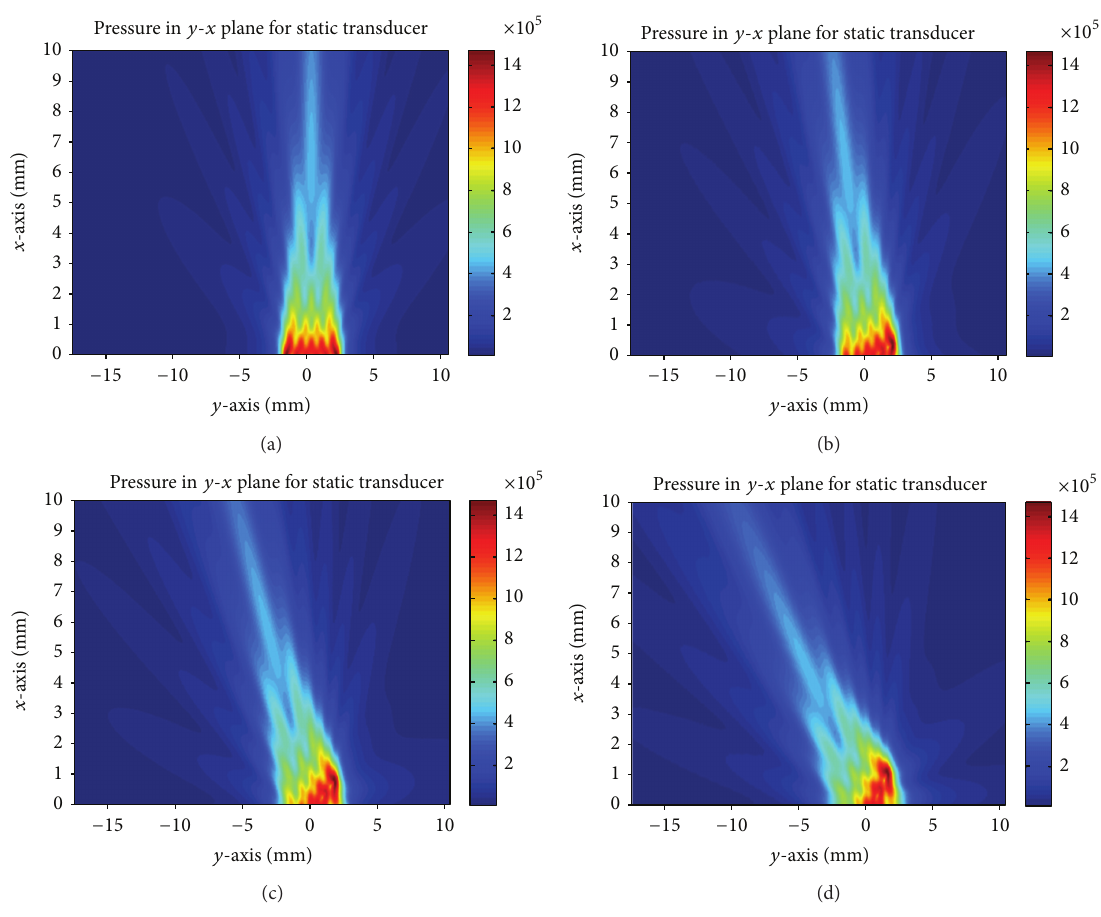
Figure 10: Acoustic pressure field generated by a traditional transducer for steering angles (a) 0 ∘ , (b) 15 ∘ , (c) 30 ∘ , and (d) 45 ∘